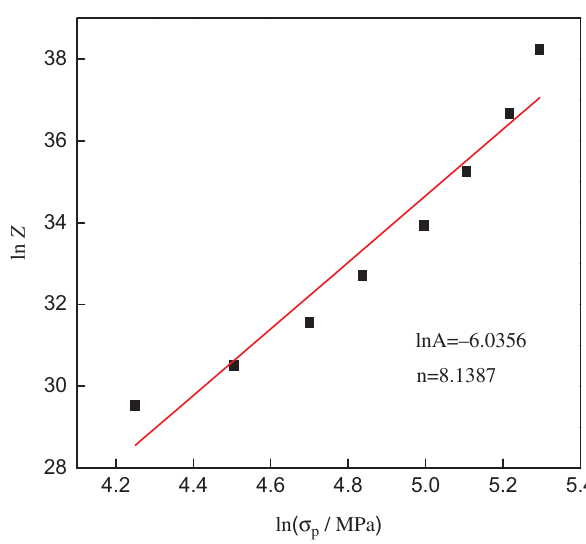
Figure 5: Relationship between ln Z and ln σ